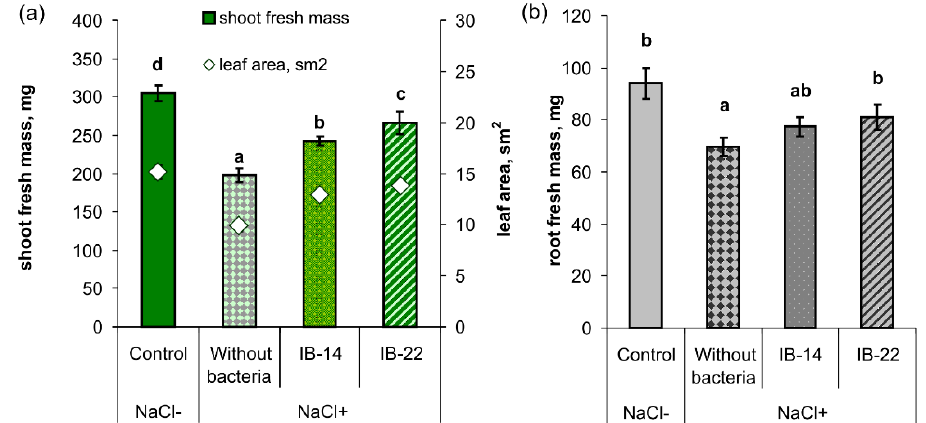
Figure 4. Effects of 100 mM NaCl and rhizospehere inoculation with P. mandelii IB -Кi14 (IB-14) and B. subtilis IB -22 (IB-22) on the shoot ( n = 40) ( a ), root fresh mass ( n = 8) ( b ), and leaf area ( n = 20) ( a ) of